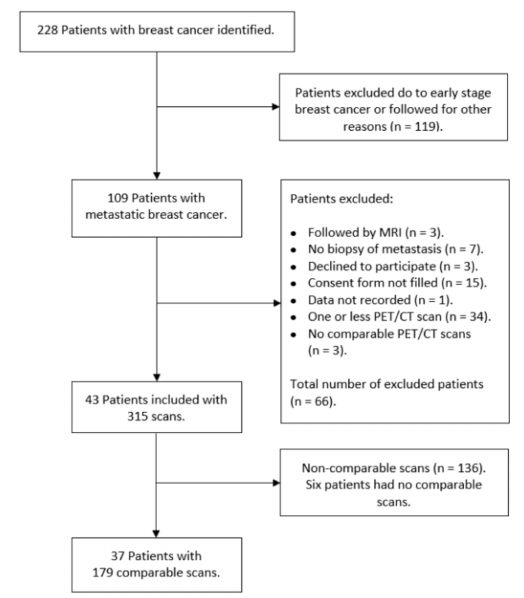
Figure 1. Flowchart over included patients and 18F-FDG-PET / CT scans.